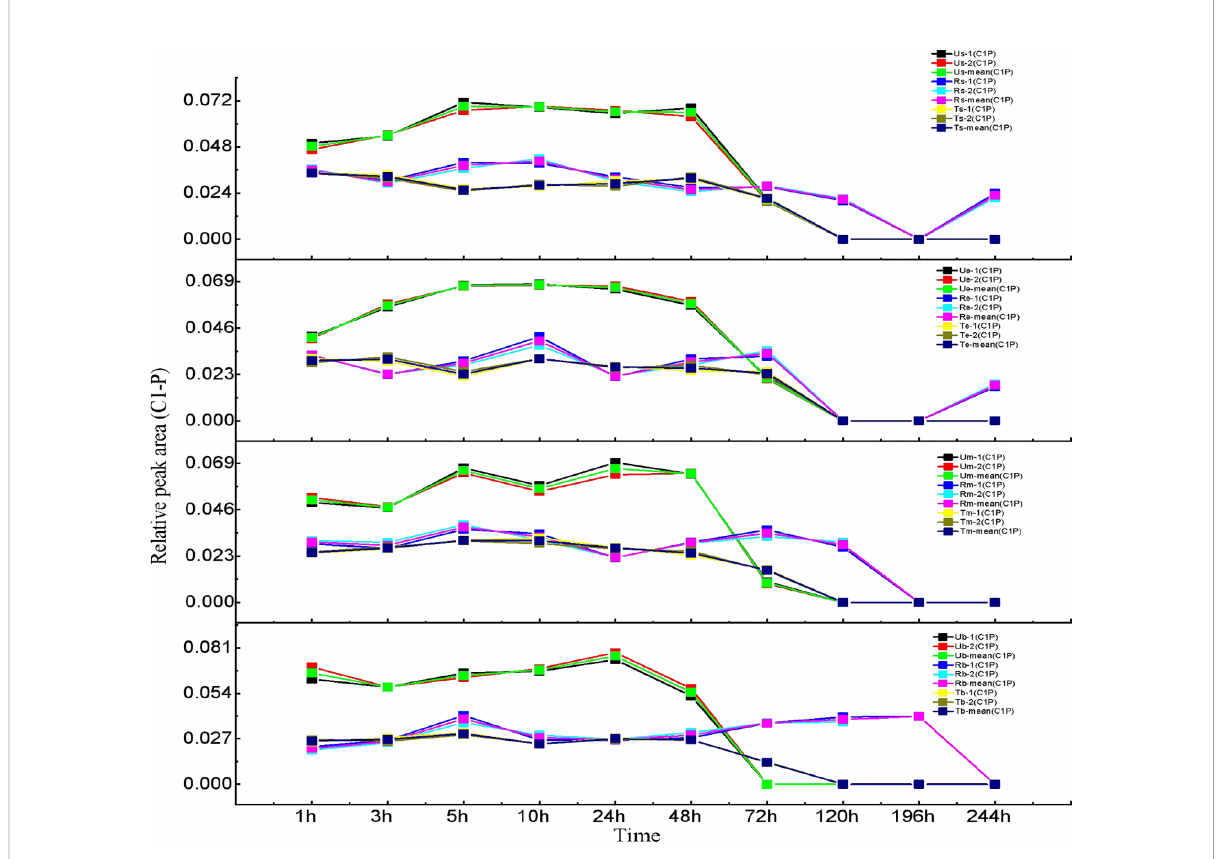
FIGURE 2 C1-P relative peak area changes of three kinds of crude oil at four different